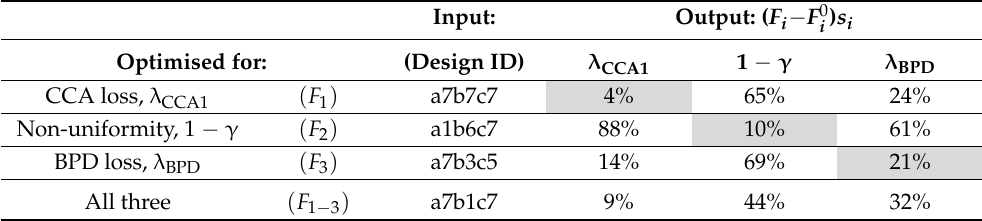
Table 4. Characteristics of the optimal geometries (inputs and